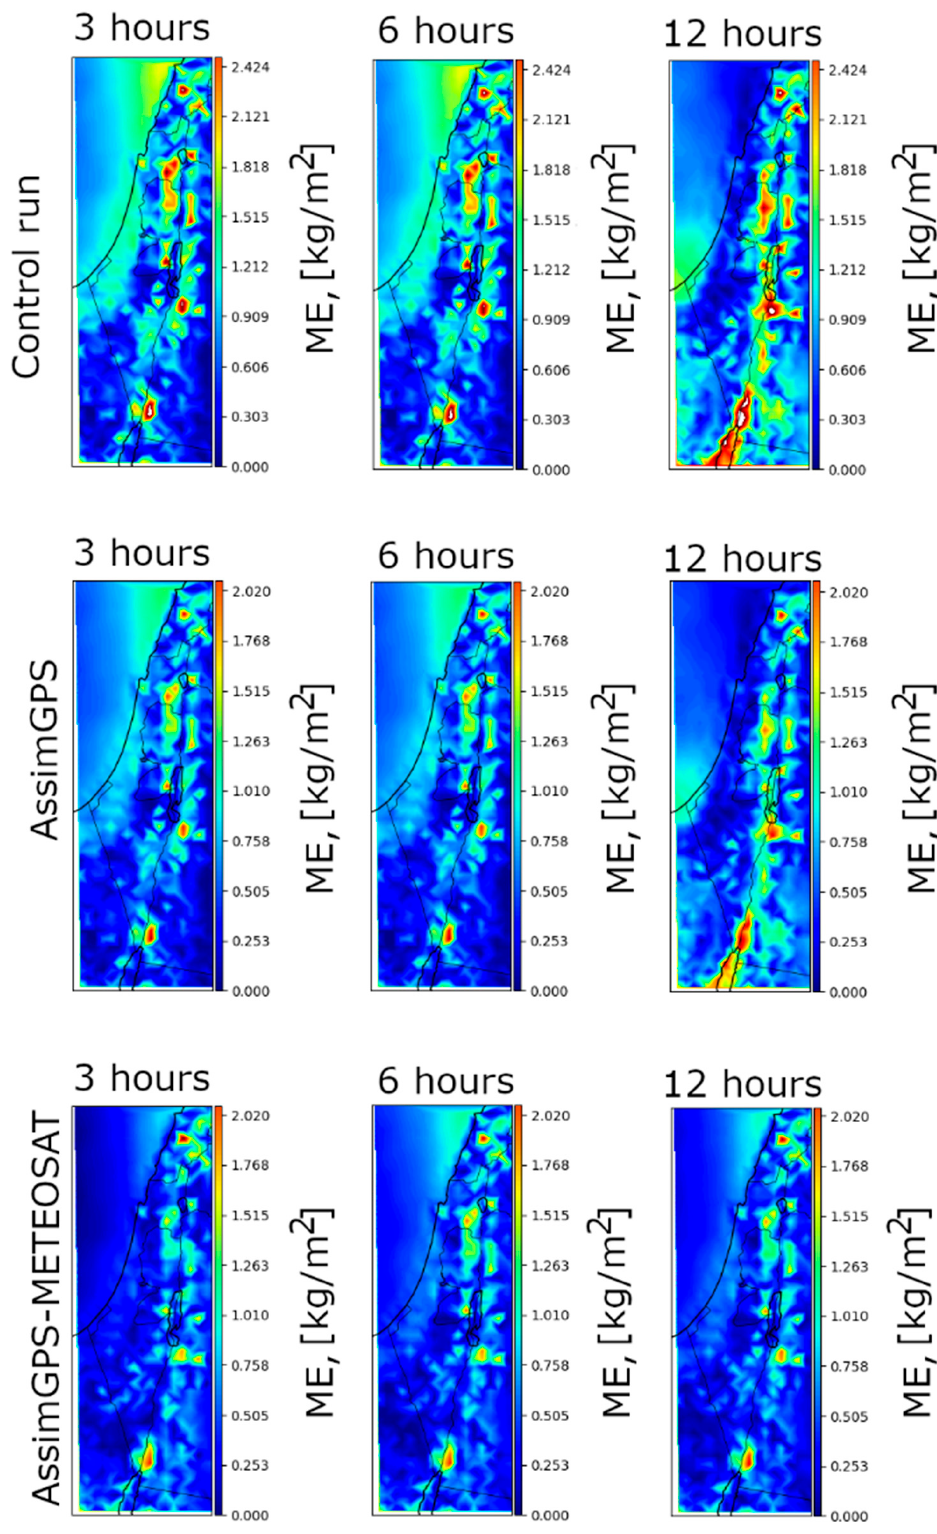
Figure 7. Mean error (ME) maps between the 2D GPS-IWV-METEOSAT and different types of WRF forecasts.